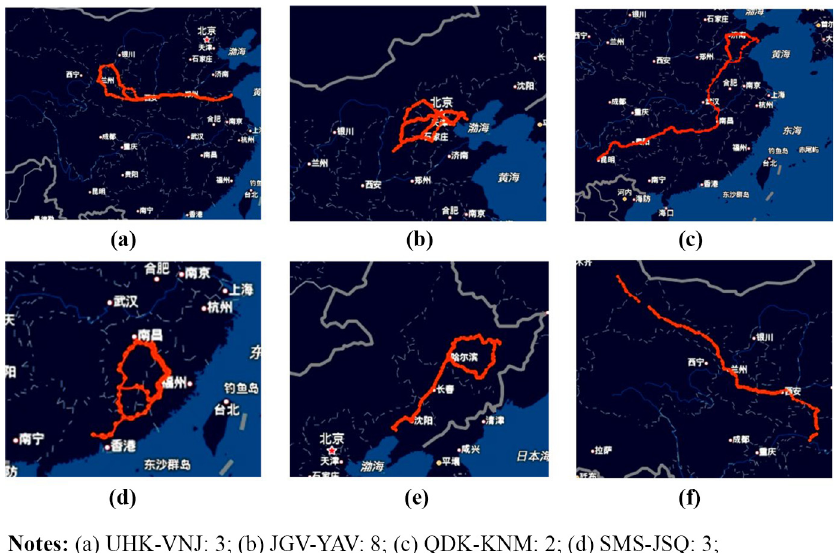
Figure 10. The railway